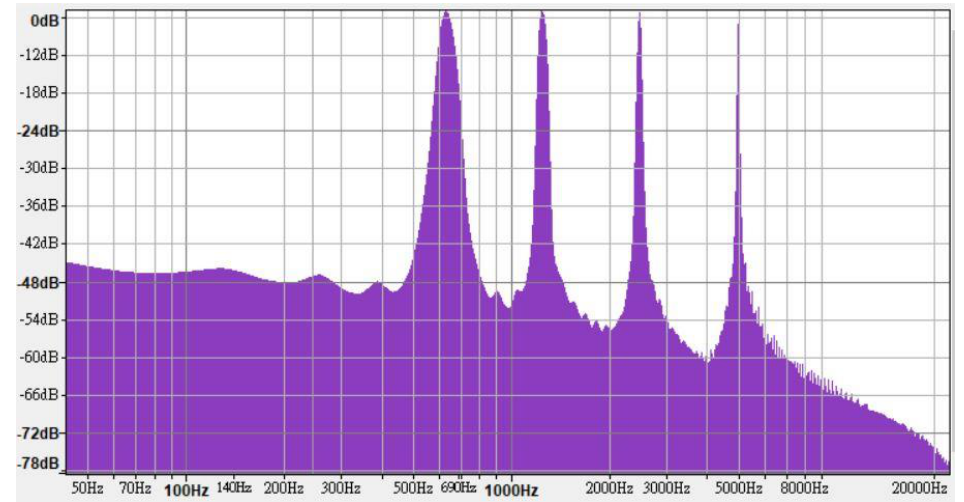
Figure 2. Frequency characteristics of high-frequency warning sound.